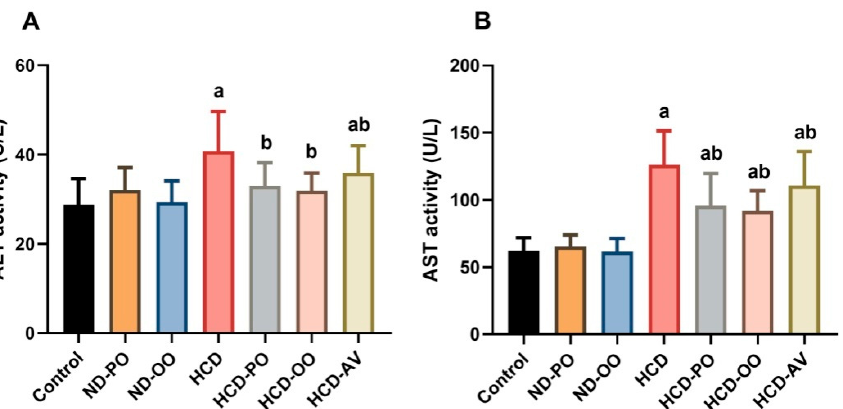
Figure 2. Serum transaminases (( A ) ALT and ( B ) AST) following treatment with palm oil (PO), olive oil (OO), or atorvastatin (AV) in high-cholesterol diet-induced hypercholesterolemia in rats. Data are expressed as the mean ± SD ( n = 7). Letters a and b indicate statistically significant differences between control rats and hypercholesterolemia rats, respectively, at p < 0.05.